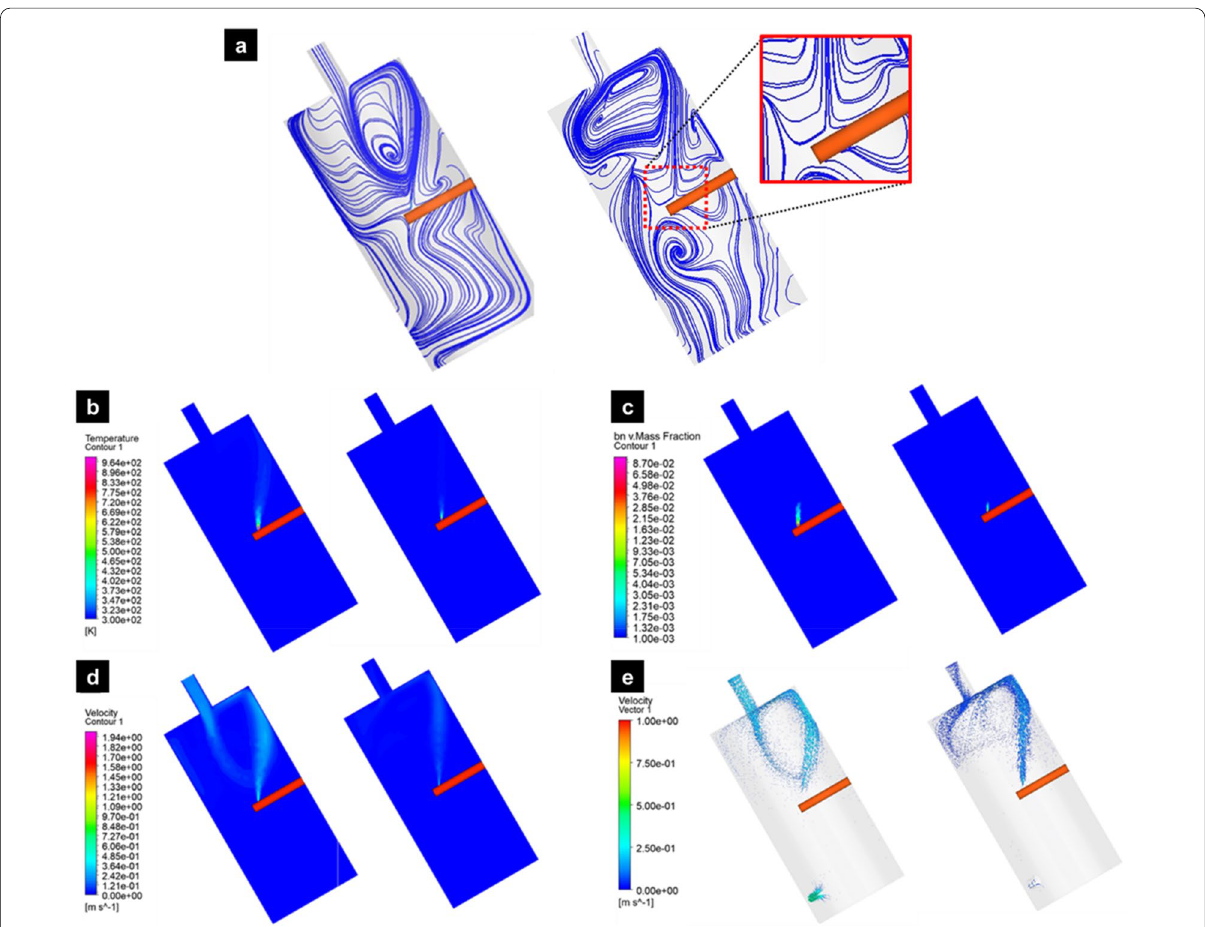
Fig. 6 Thermo‑fluid simulation results in the reaction chamber at (left) 2 and (right) 12 bar. a Streamlines, b temperature distribution, c BN mass fraction, d velocity distribution, e velocity